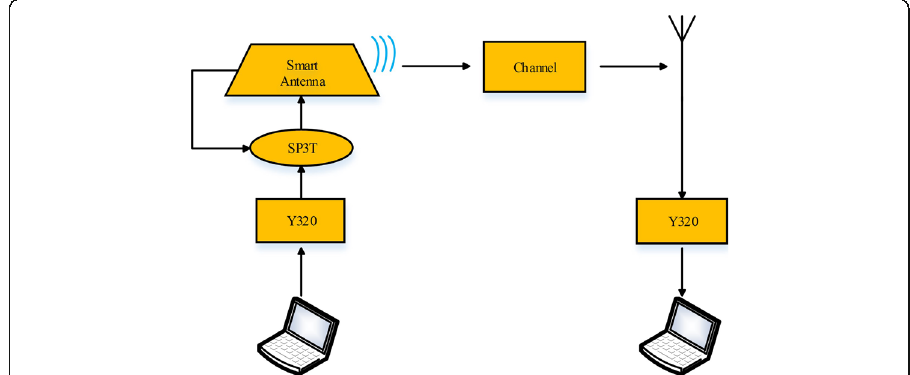
Fig. 16 Block diagram of the EVM measurement